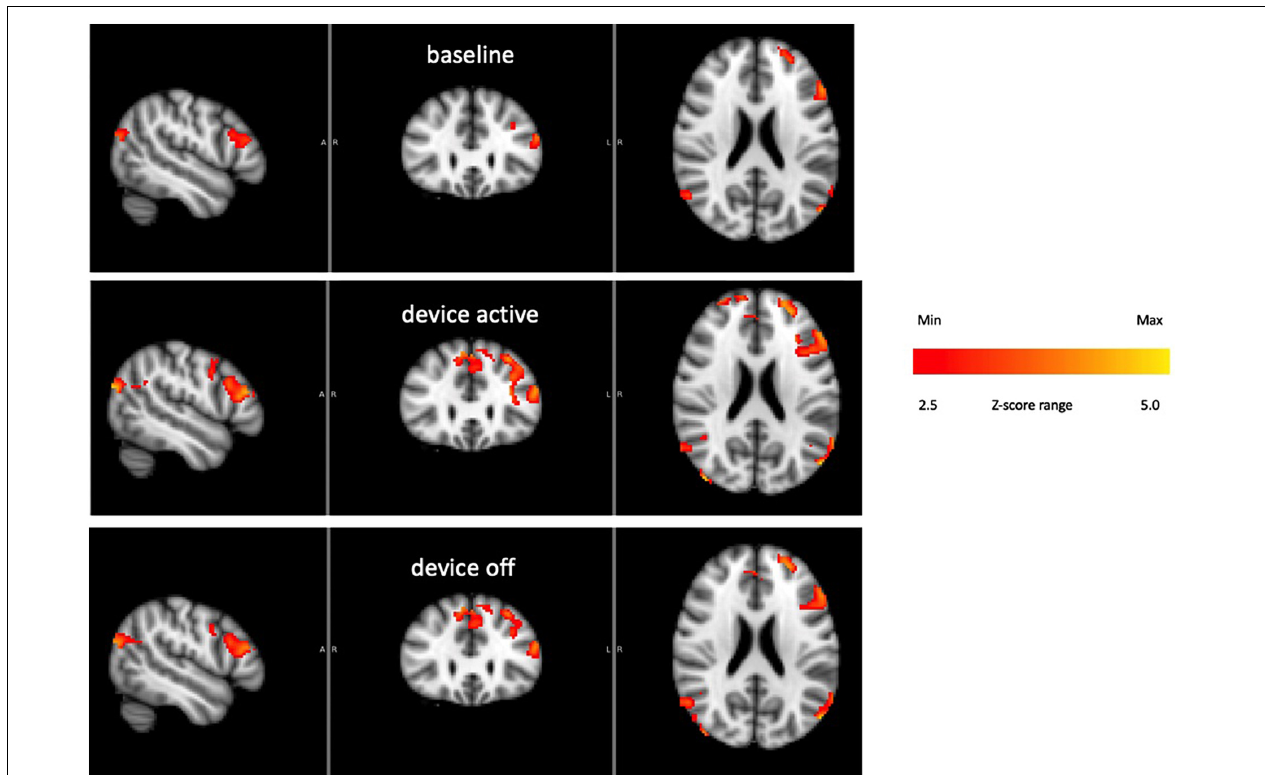
FIGURE 9 | Frontoparietal network activity over the three phases of the BOLD run (all subjects). The color bar show relative z-score